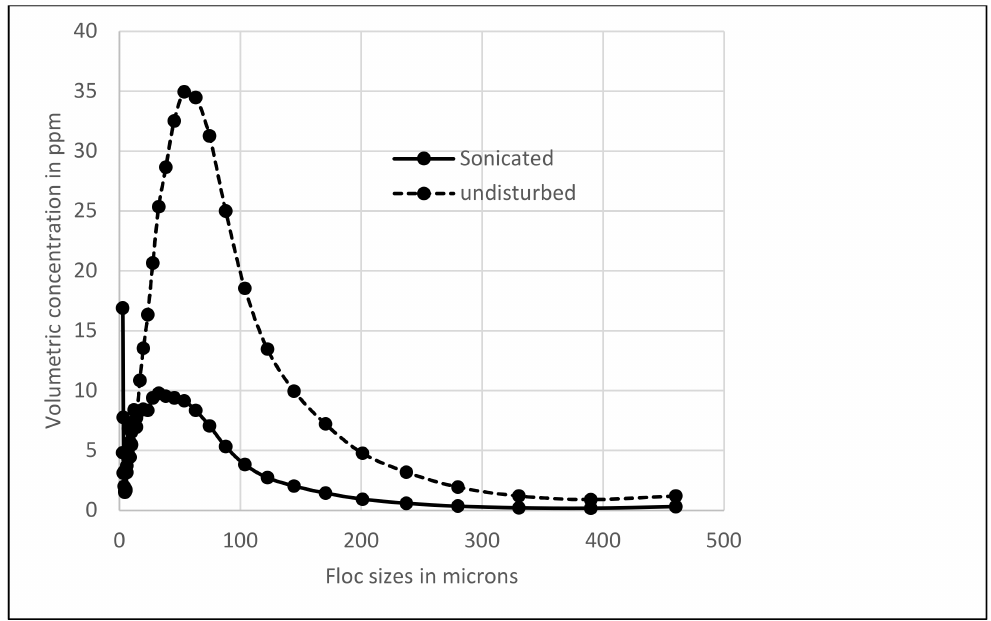
Figure 3. Size distribution of eroded sediment at the shear stress step of 0.33 Pa and age of deposit equal to 160 h.